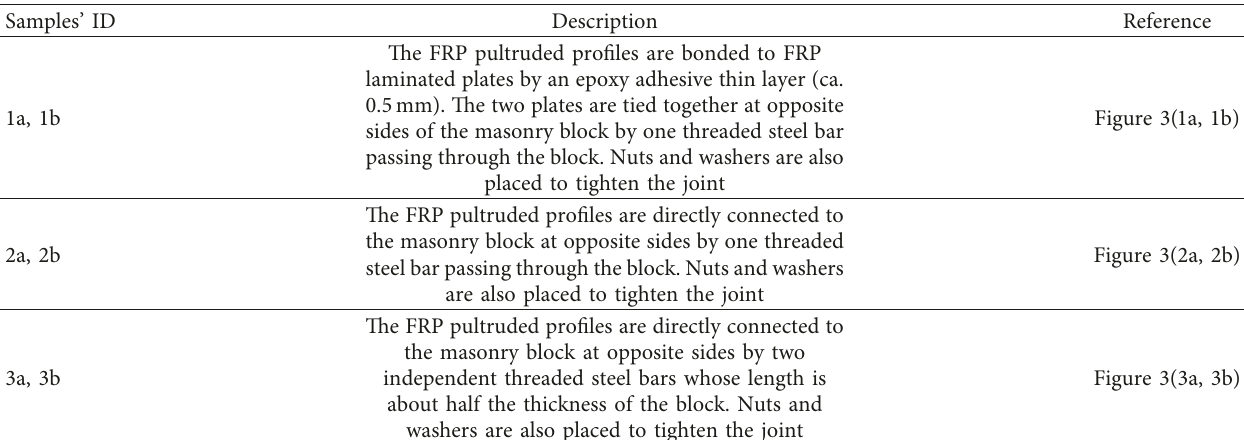
Figure 2: Output of preliminary finite element model: (a) model view; (b) stress intensity contour plot. Table 1: Description of tested